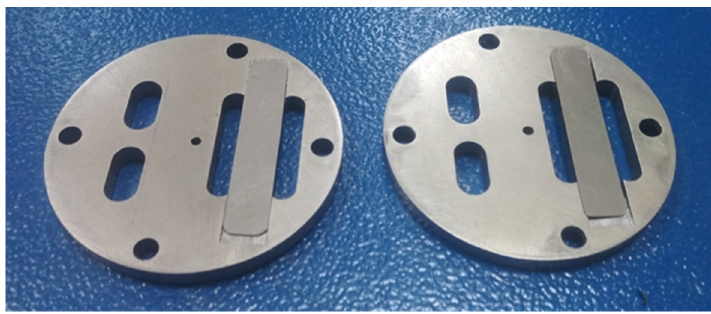
Figure 4. Reed valves installed in the valve body of the compressor section.